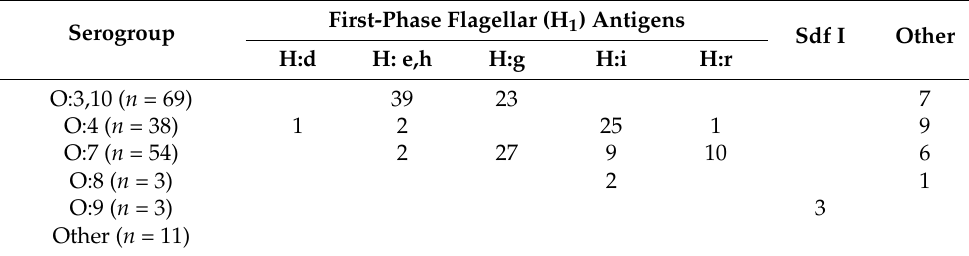
Table 1. Molecular characterization of S. enterica isolates.